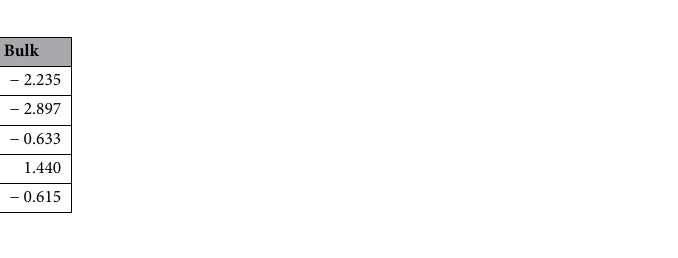
Table 3. Bader charge of